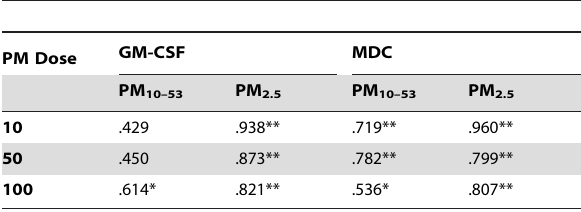
Table 3. Spearman’s Rank Order Correlation Coefficients Relative to Unstimulated